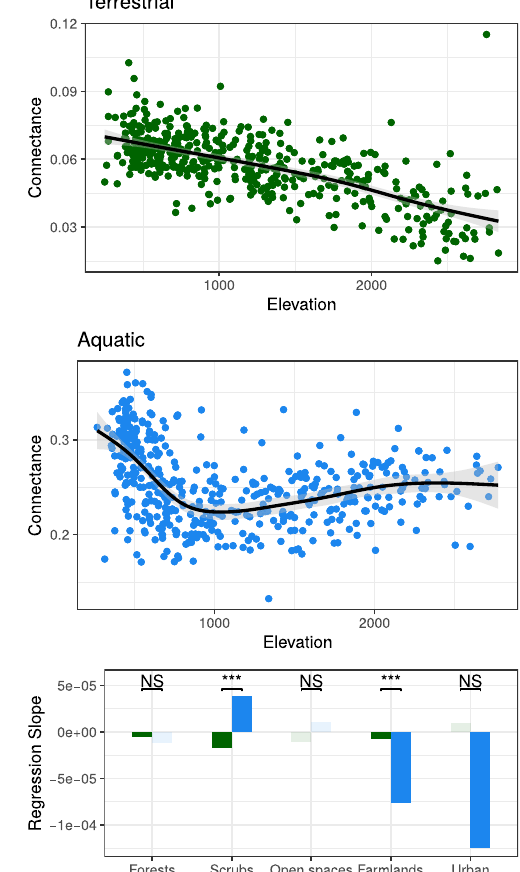
subsetted food webs of each dominant land-use type. Solid green/blue bars indi- catesigni fi cantslopes,likewisefadedcoloursnon-signi fi cantones.Thesigni fi cance ofterrestrialversusaquaticleast-squaresslopecomparison(two-tailed)isindicated above the bars (*** P <0.001, NS non-signi fi cant; details in Supplementary Fig.